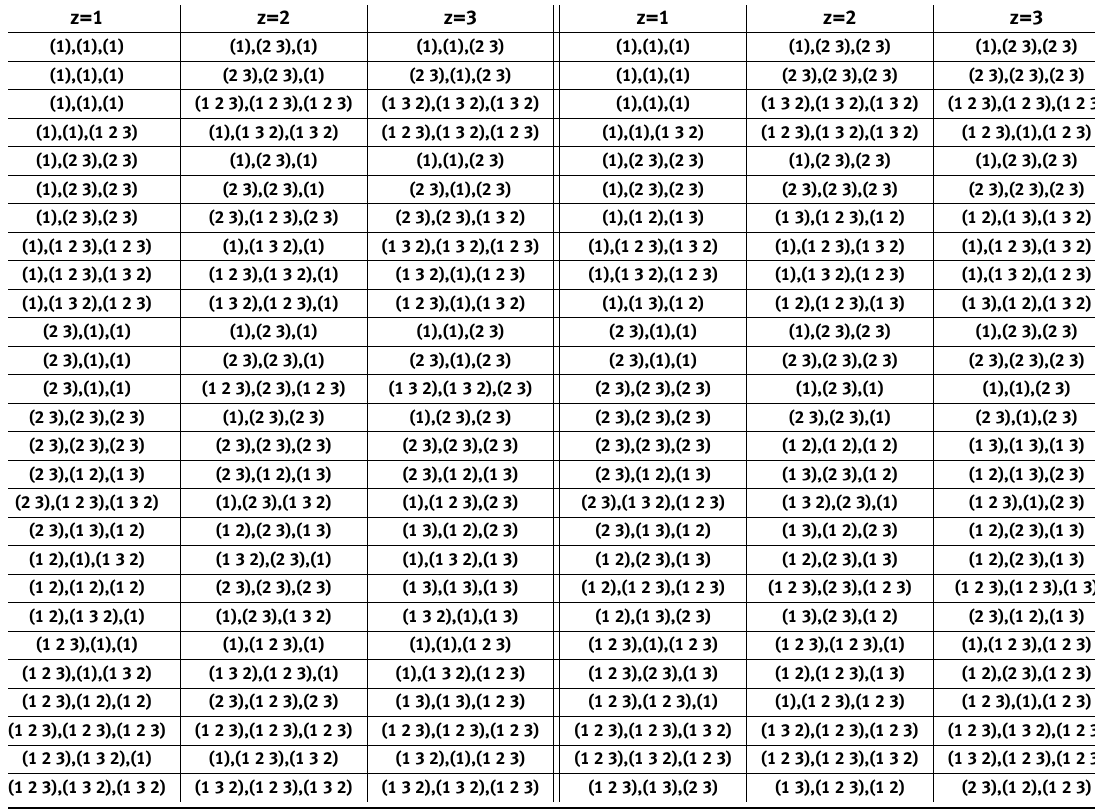
Table 4. Isomorphism classes of ternary f -quandles of order